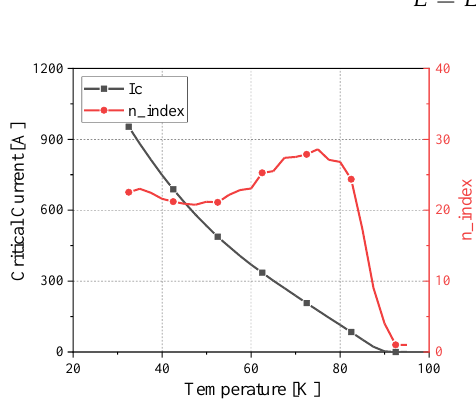
Figure 1. Critical current of PA1212 2G HTS tape at different temperatures.